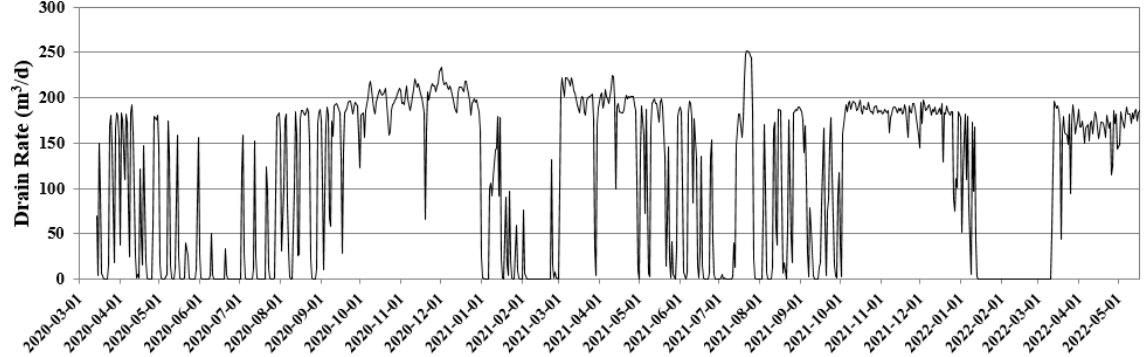
Figure 10. Water drain rates from sand dam.